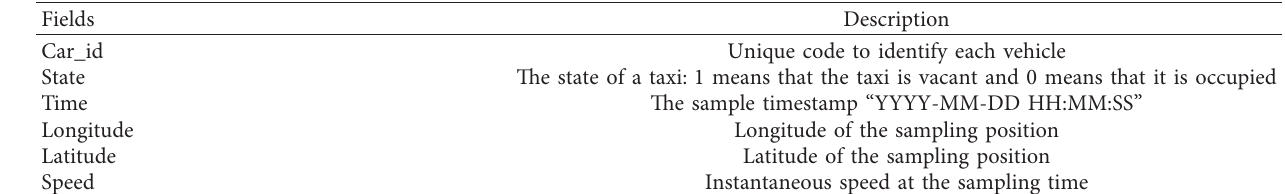
Table 1: Taxi data